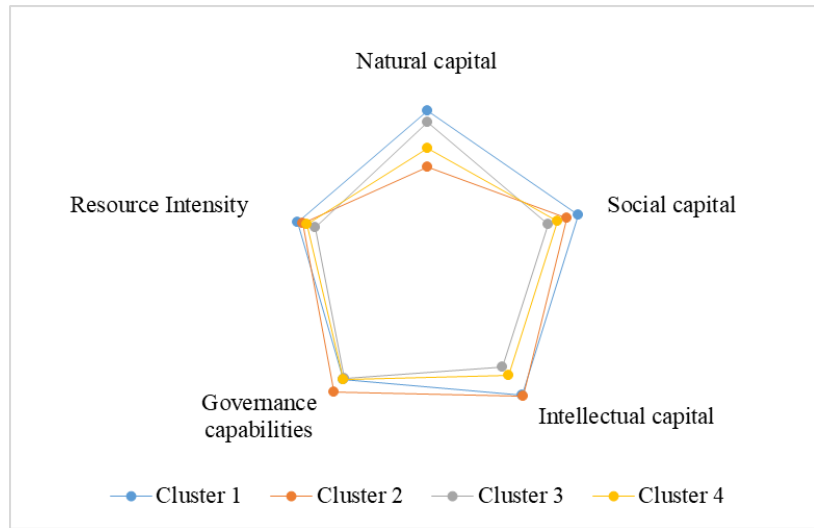
Figure 4. Dendrogram reflecting clusters of the sustainability models. Source: authors’ projection.